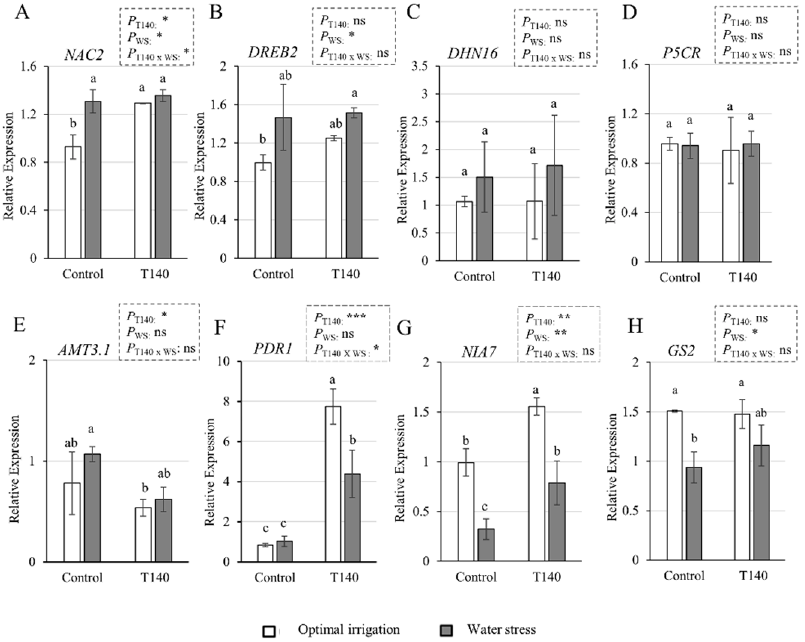
Figure 7. Effect of strain T140 compared to plants not treated with T140 (control) on the expression of eight genes related to drought responses or N metabolism: ( A ) NAC2 , ( B ) DREB2 , ( C ) DNH16 , ( D ) P5CR , ( E ) AMT3.1 ( F ) PDR1 , ( G ) NIA7 , and ( H ) GS2 in N-fertilized 25-week-old wheat plants under optimal irrigation and water stress (1/2 watering applied) conditions. Data are the means of three technical replicates from three biological replicates for each treatment and irrigation condition ( n = 3). Data are displayed as the relative quantity (RQ, 2 −ΔΔ Ct ) + standard deviations of the target genes compared to the quantity of the reference gene (ubiquitin). Different letters above the bars indicate significant differences according to one-way analysis of variance (ANOVA) followed by Duncan’s test ( p < 0.05). For each set of data, the effect of significance was determined using a two-way ANOVA for “T140 application”, “WS”, and their combination (***: p < 0.001; **: p < 0.01; *: p < 0.05; ns: no statistical differences).